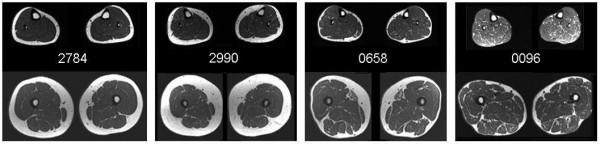
Transaxial magnetic resonance images at the levels of mid-calf (top slice images) and mid-thigh (bottom slice images) of the subjects in the study. Bright/white signals in these images are highlighting adipose tissue within these anatomical sections. Dark signals represent either muscle tissue within sections or the background of the images. Subject GL2784 is a healthy 24 year old woman whose MRI showed no infiltrated fat into calf muscle, and only small amount of infiltration in the thigh. Subject GL2990 is a normal 50 year old woman who had somewhat increased subcutaneous (sc) fat in the calves and mid-thigh with slightly more infiltration of fat into the muscle compared to the images of subject GL2784. Subject GL0658 is a 49 year old FPLD3 patient (heterozygous for mutation PPARG F388L) whose scans show moderate loss of sc fat in both the calves and mid thigh and moderate levels of fat infiltration. Subject GL0096 is a 63 year old FPLD2 patient (heterozygous for mutation LMNA R482Q) whose scan shows total sc fat loss in the calves, major sc fat loss in the mid-thigh and marbled appearance of muscle tissue due to severe amounts of fat being stored within the muscle.